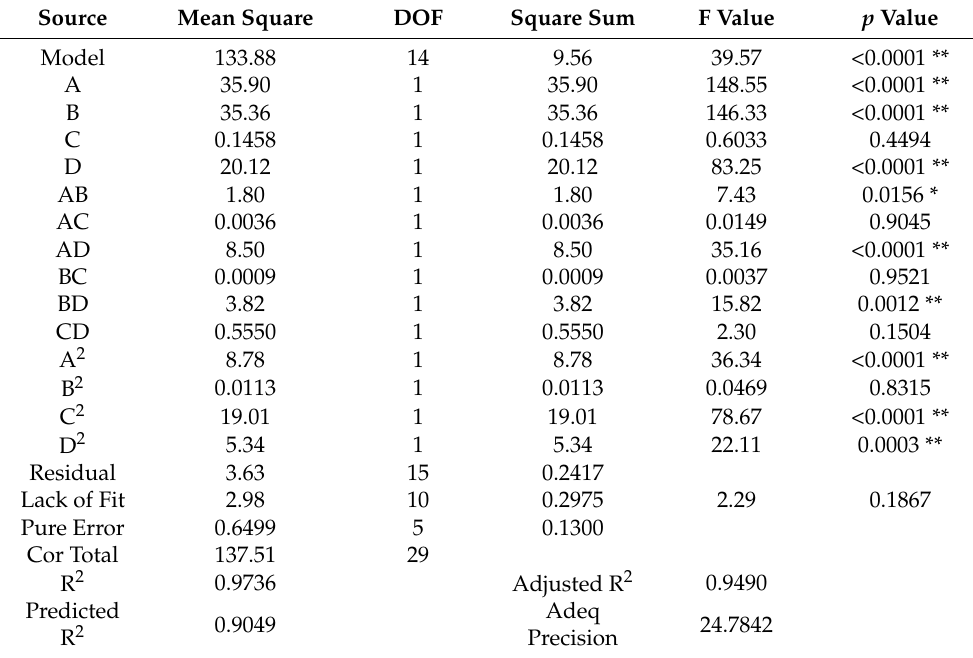
Table 6. Analysis results of quadratic regression model of soil transport